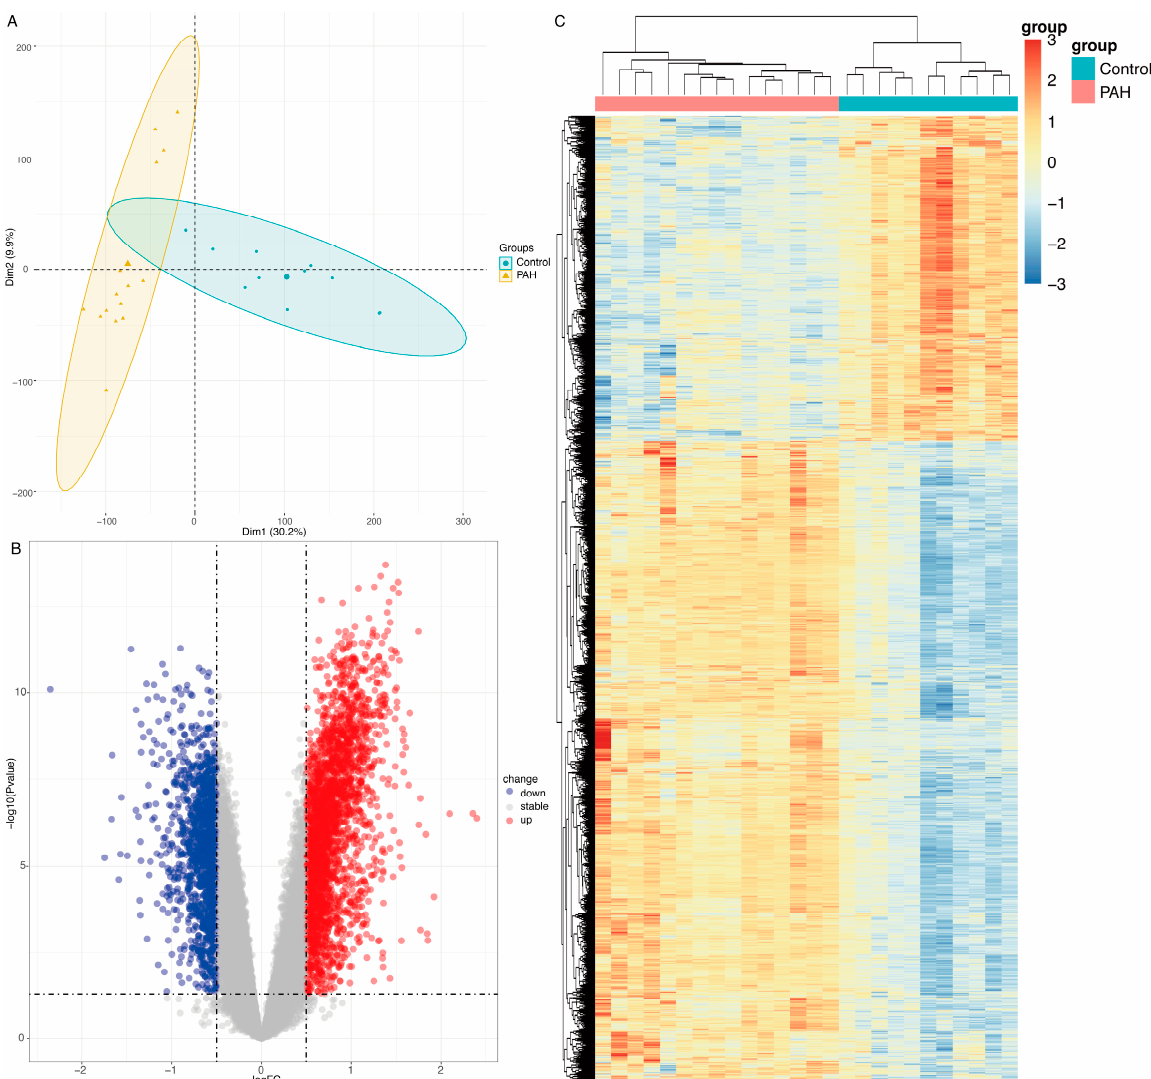
Figure 1. PCA, volcano plot and heatmap for DEGs identified in the GSE113439 dataset. ( A ) PCA plots. Blue dots represent control patients and yellow triangles represent PAH patients. ( B ) Volcano plot of DEGs ( p -values < 0.05 and |Log2 fold change| > 1) identified through the GSE113439 dataset. Each dot represents an individual gene. Red dots denote upregulated DEGs, while blue dots represent downregulated DEGs. ( C ) Heatmap of all DEGs. Red blocks represent upregulated DEGs and blue blocks represent downregulated DEGs in those groups. PAH, lung tissues of pulmonary arterial hypertension patients; Control, normal lung tissue; DEGs, differentially expressed genes.